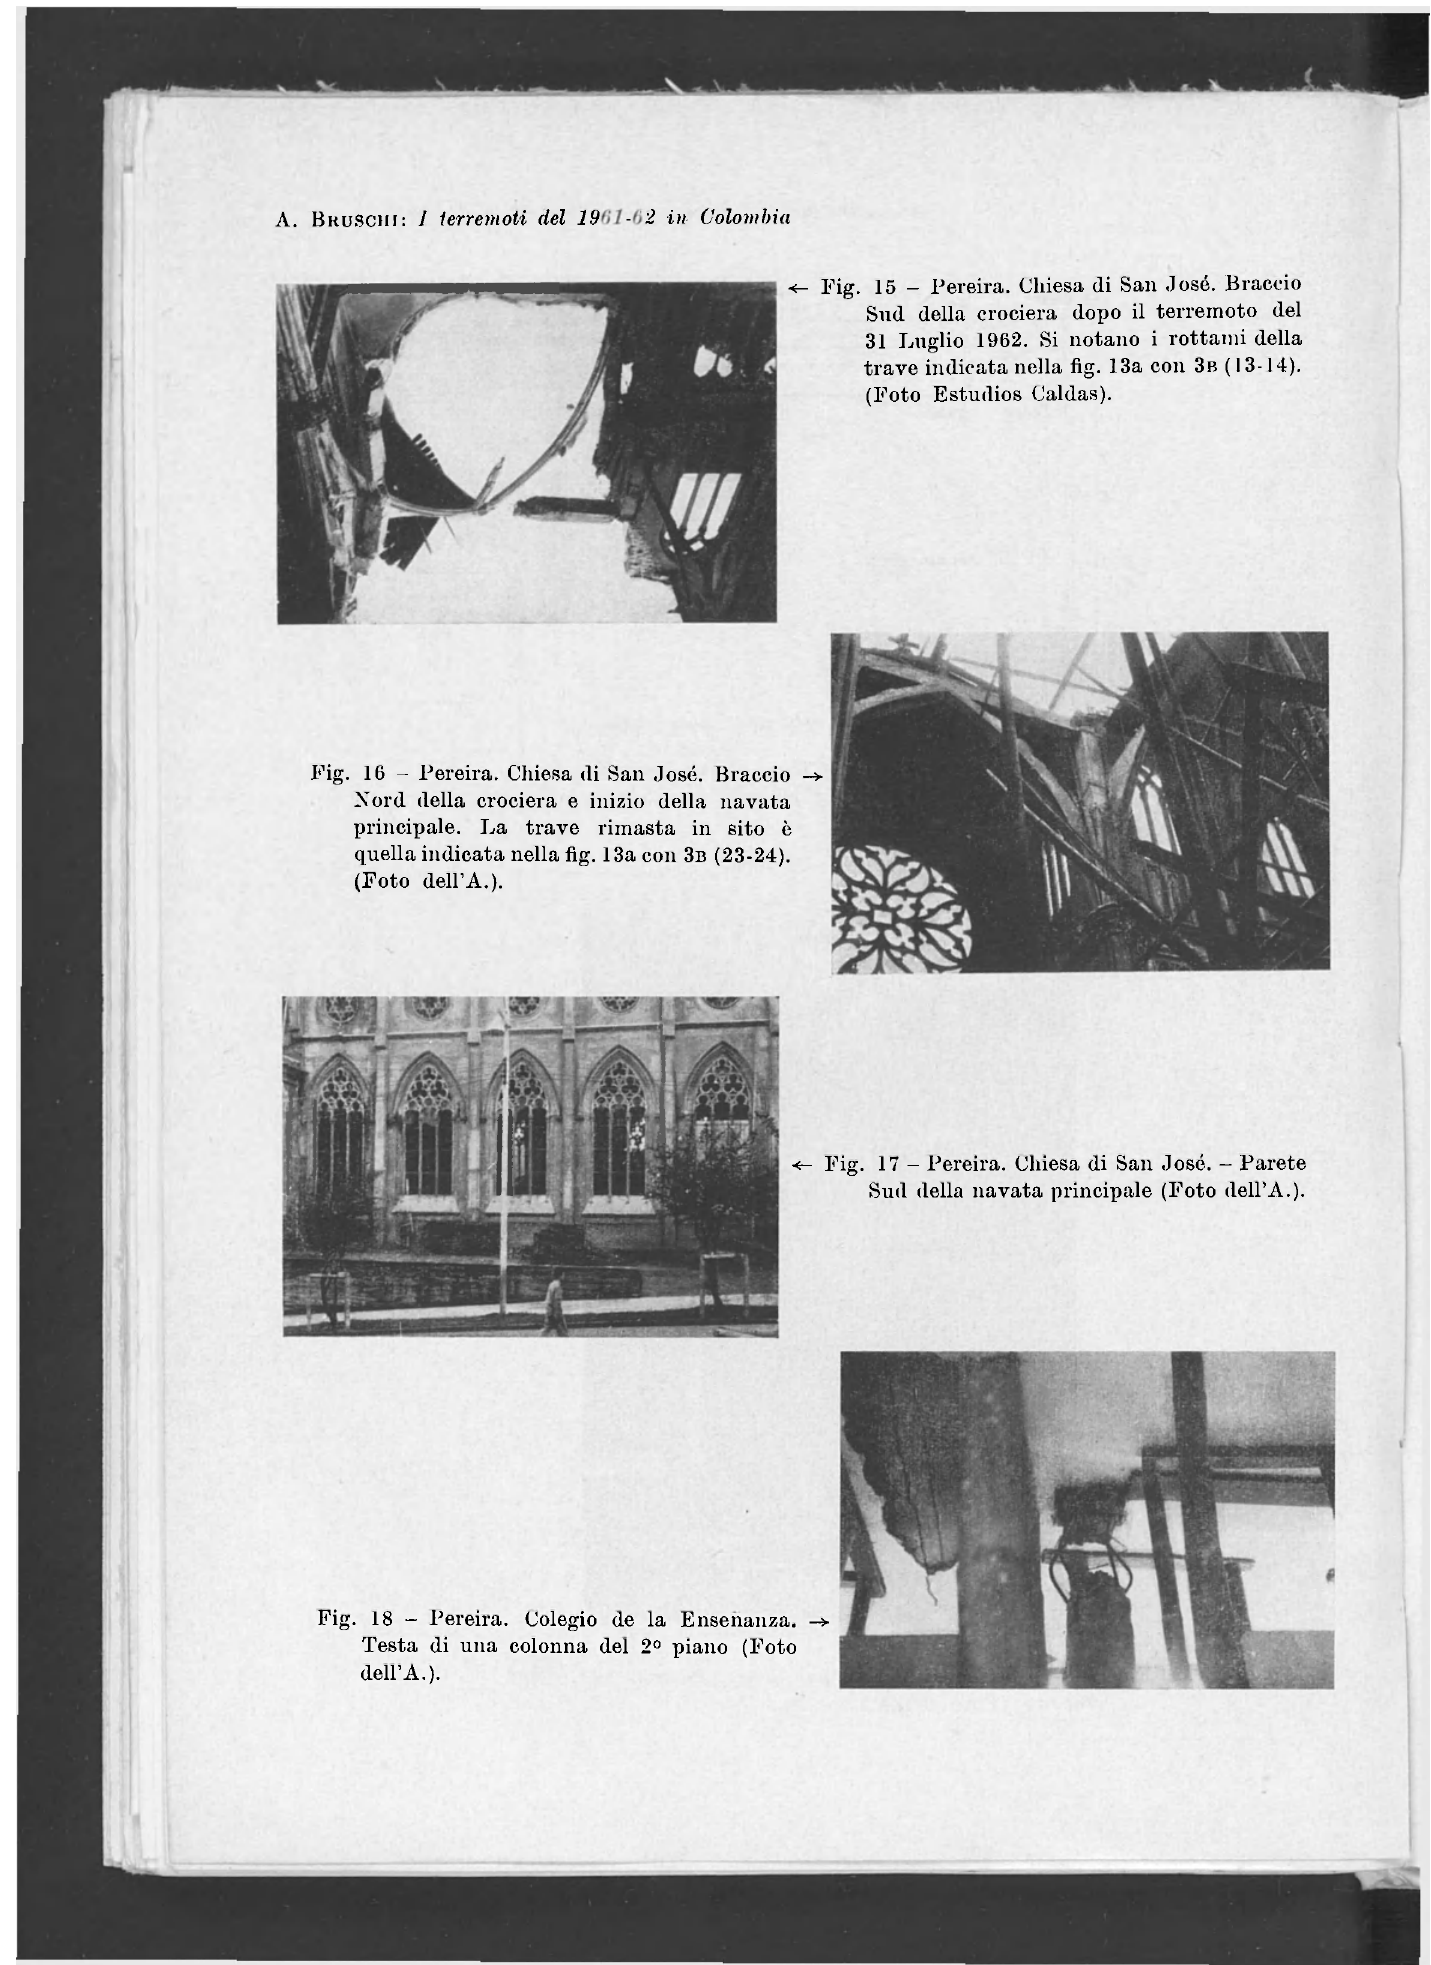
Fig. 18 - Pereira. Colegio de la Ensenanza. -> Testa di una colonna del 2° piano (Foto dell'A.).